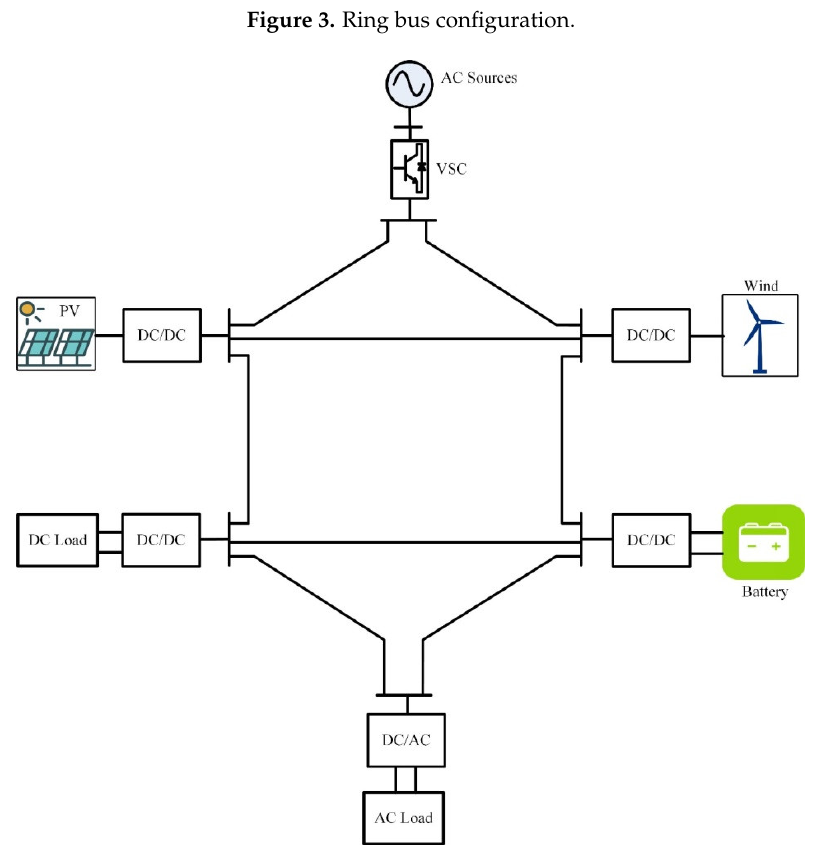
Figure 3. Ring bus configuration. Energies 2019 , 12 , 1001